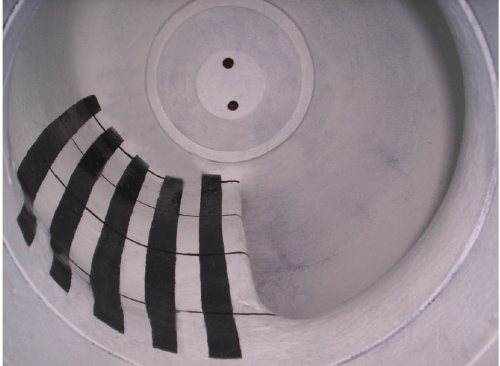
Figure 6: Impeller marked for cavitation observation.